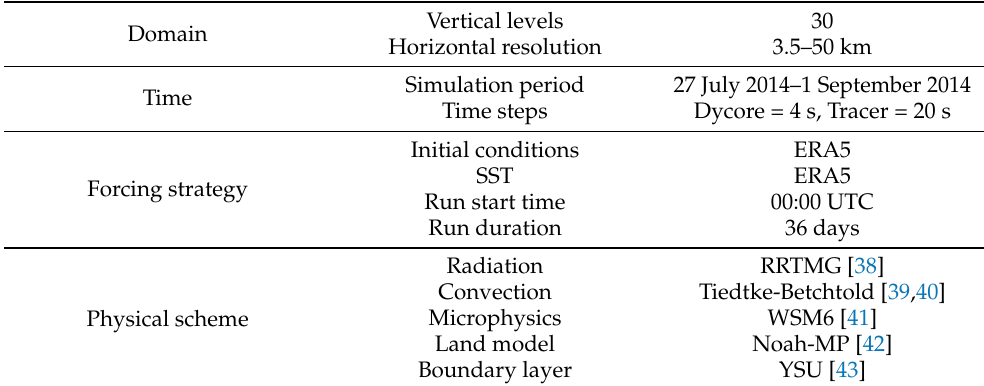
Figure 1. The variable-resolution (VR) mesh of GRIST with 2,427,967 horizontal cells (3.5–50 km). The filled color area denotes the surface elevation used in GRIST (m). The black contour with a label presents the horizontal resolution (km), and the black polygon indicates the study region. Table 1. Model configuration of GRIST used in the